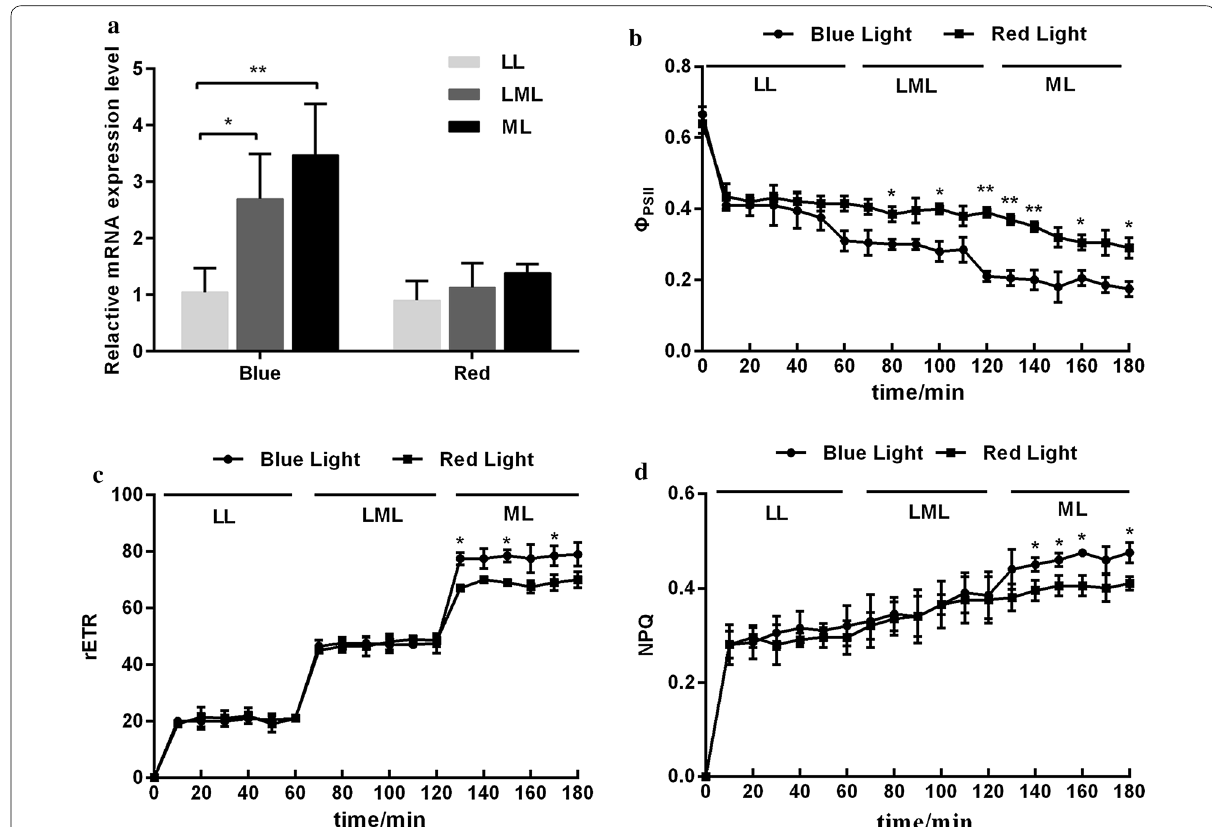
Fig. 2 Responses of Lhcx3 ( a ), Φ PSII ( b ), rETR ( c ) and NPQ ( d ) of P. tricornutum to blue or red light. LL, LML, and ML represent the light intensities of 30 μmol